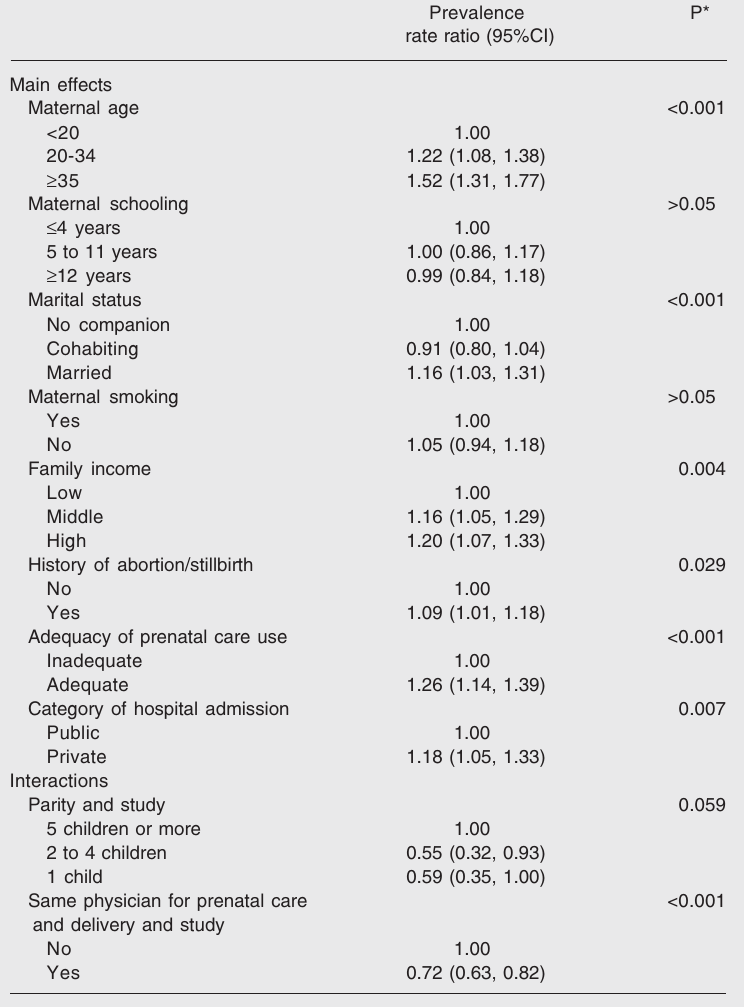
Table 4. Multivariable analysis of risk factors for cesarean section in a joint model (Ribeirão Preto, 1994 and São Luís, 1997/1998).